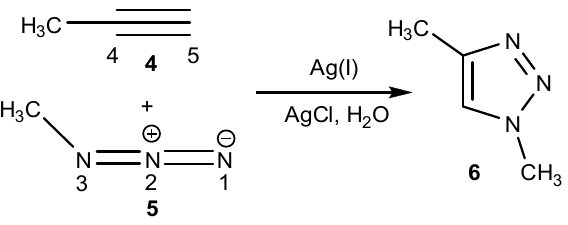
Figure 3. AgAAC reaction between 4 and 5 .